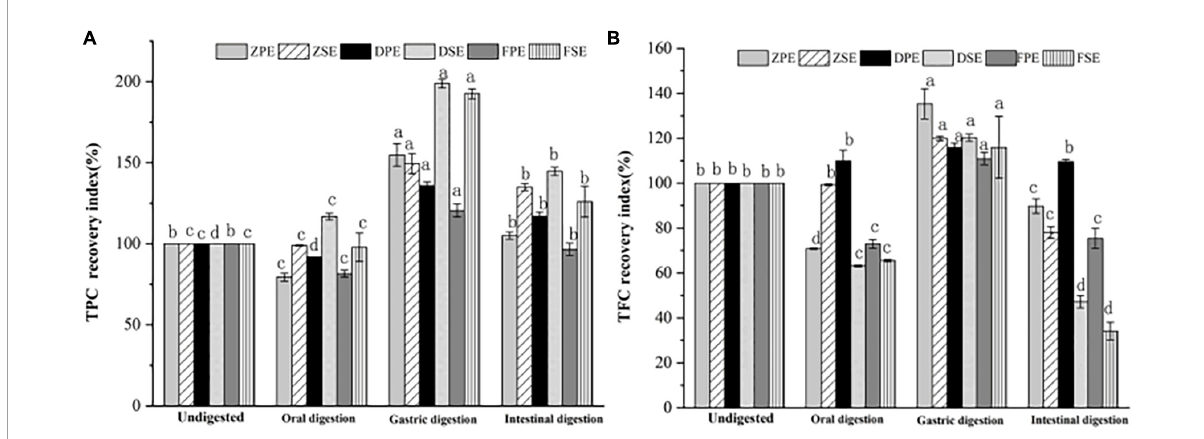
FIGURE4 The recovery rate of TPC (A) and TFC (B) after simulated in vitro digestion of different stages. Values are presented as means ± SD ( n = 3), ( p < 0.05). ZPE, Zihei peel extract; DPE, Dahong peel extract; FPE, Fenhong peel extract; ZSE, Zihei sarcocarp extract, DSE, Dahong sarcocarp extract; FSE, Fenhong sarcocarp